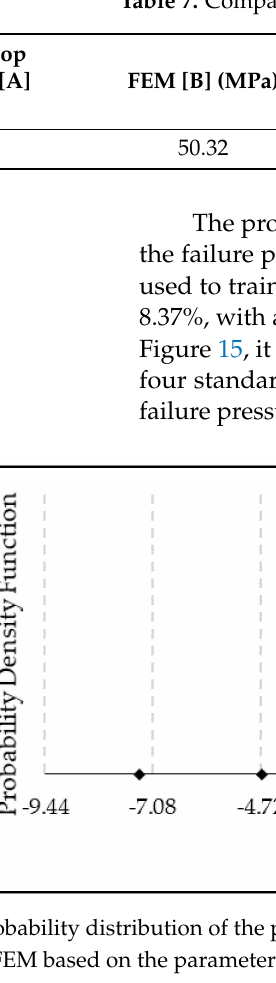
Table 7. Comparison of the intact pressure values of the pristine pipe.